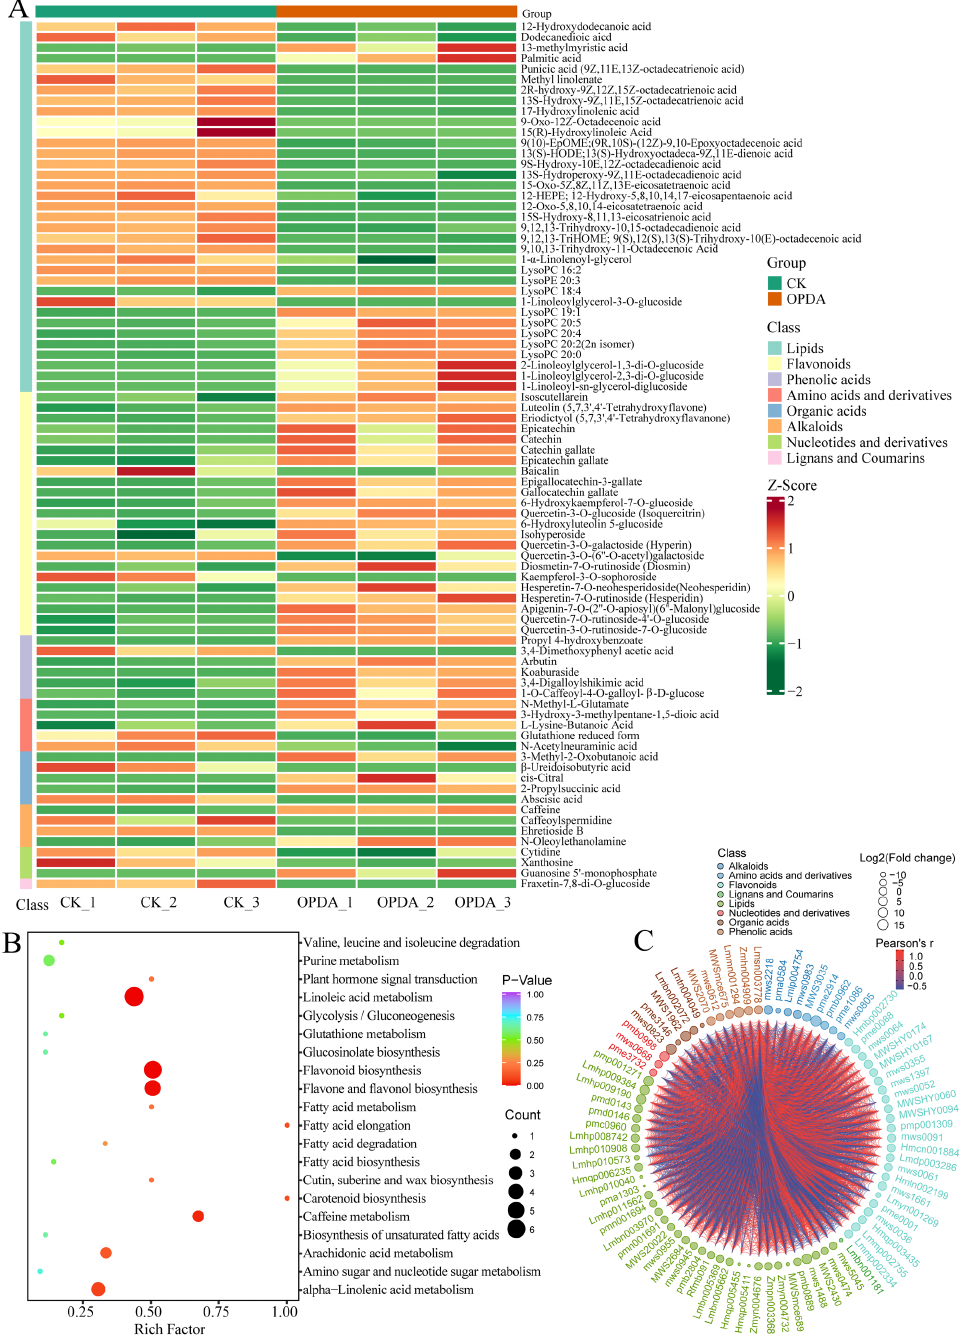
Figure 2. Cluster analysis of differentially changed metabolites in Pohlia nutans under OPDA treatment. ( A ) Heatmap showing the differentially changed metabolites (DCMs) sorted by metabolite classes under OPDA treatment. ( B ) KEGG enrichment analysis of DCMs between two groups. Rich factor represents the ratio of the DCMs amount to the total amount of annotated metabolites in the pathway. ( C ) Chord diagram showing the correlation among DCMs identified by Pearson correlation analysis. The outer layer is the metabolite identifier. The point size in the middle layer represents the log 2 (Fold Change) value. The inner line reflects the Pearson correlation coefficient (r) between metabo- lites. Positive correlation is represented by the red line, while negative correlation is represented by the blue line. The differential metabolite pairs with |r| ≥ 0.8 and p < 0.05 were